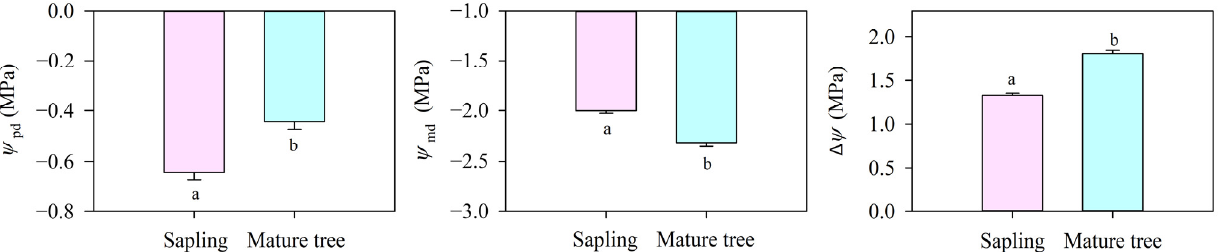
Figure 3. Predawn water potential ( Ψ pd ), midday water potential ( Ψ md ), and soil-to-leaf water potential gradient ( ∆Ψ , calculated as Ψ soil − Ψ leaf - ρ gh ) for P. euphratica at different sizes. Vertical bars represent the standard error of the means ( n = 5). Different letters at each column indicate significant differences between the saplings and the mature trees ( p < 0.05).